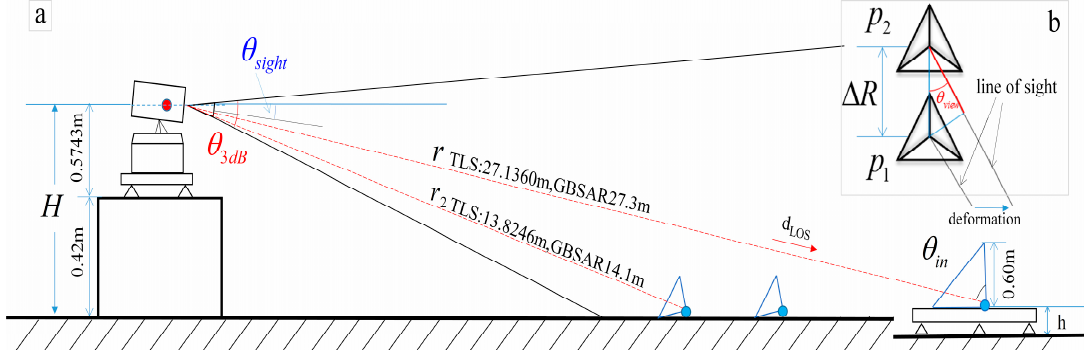
Figure 5. Another test for “artefact” using a 2 m GB-SAR. ( a ) Shows the set up of the test, CR1 was about 10m from GB-SAR and ( b ) is the amplitude image of the CR which is shown as long bright spot.